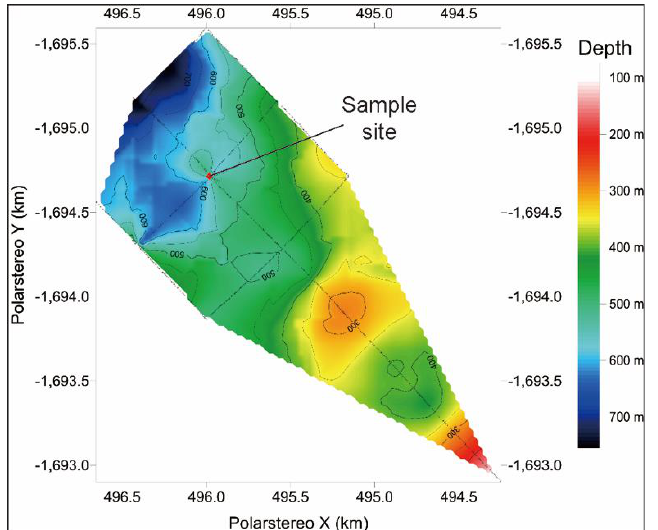
Figure 3. Ground-penetrating radar (GPR) data plotted using the program Surfer. The GPR data were acquired using a MALÅ Rough Terrain Antenna (RTA) system. The control unit linked to global positioning system (GPS) receiver measured signals with 25 MHz center frequency, 4.4 m transmitter-receiver separation, 1 trace s −1 record, 13,000 ns time window, and 8 stacks. The raw data were post-processed by background removal, gain, and Kirchhoff migration using the program Reflexw. The radio wave velocity was employed as 0.20 m ns −1 for snow (0–20 m depth), 0.19 m ns −1 for firn (20–50 m depth), and 0.17 m ns −1 for ice (>50 m depth) [46] .